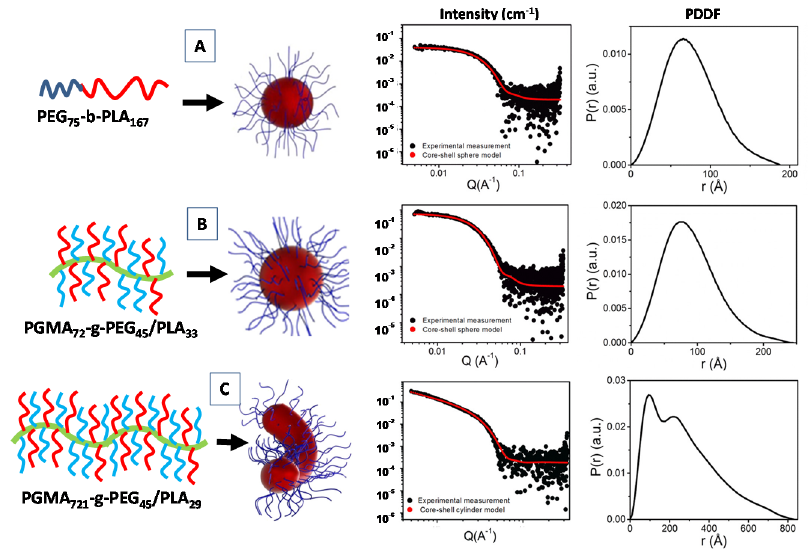
Figure 5. Structural characterization of the SAXS form factor P ( q ) and pair distance distribution function (PDDF) analysis for the poly(ethylene glycol)-b-poly(lactic acid) (PEG 75 -b-PLA 167 ) diblock copolymers system ( A ), and the poly(ethylene glycol)-b-poly(lactic acid)-b-poly(ethylene glycol) PGMA 72 -g-PEG 45 / PLA 33 ( B ) and PGMA 721 -g-PEG 45 / PLA 29 ( C ) graft copolymer systems. Adapted with permission from [71], Copyright 2019 American Chemical Society.